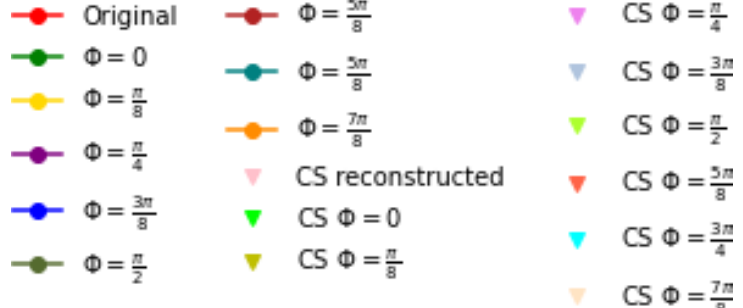
Figure 8. Legend for Figure